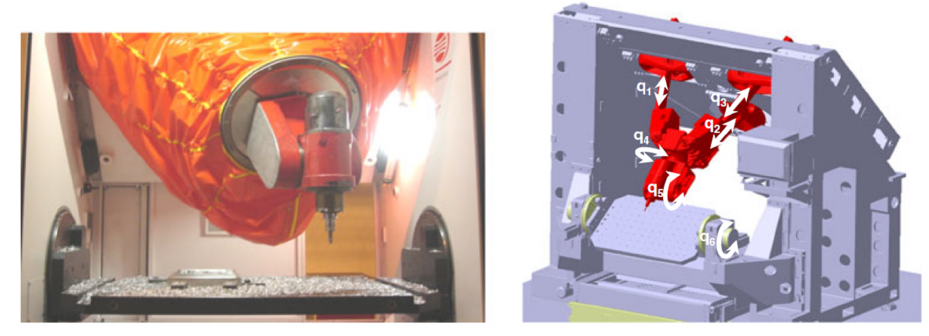
Figure 1. Tripteor X7 Parallel Kinematic Machine